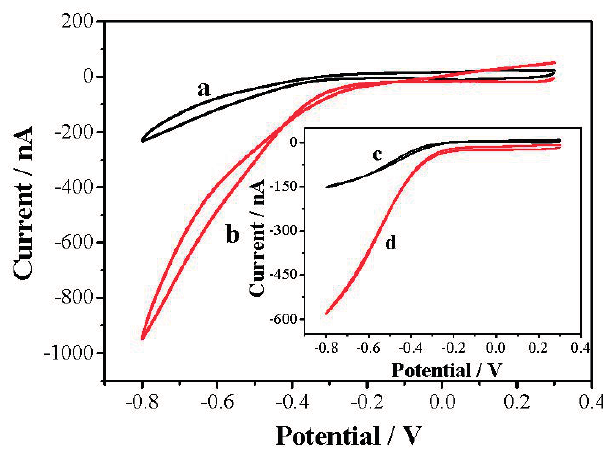
Figure 7. Response of rGN-COOH/UMEA in absence (a) and presence (b) of DO. The inset shows the response of bare UMEA in absence (c) and presence (d) of